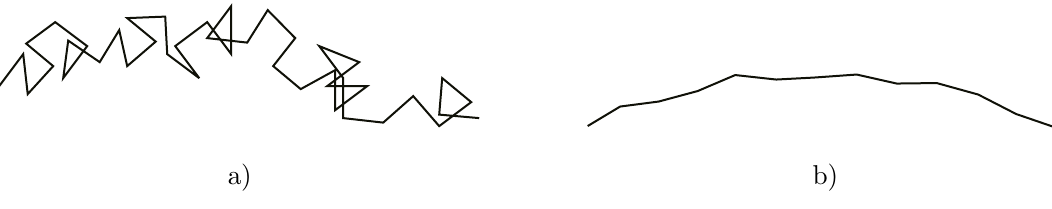
Figure 2 . Typical path shapes, a) for (cid:15)M (cid:28) 1 and b) for (cid:15)M (cid:29)